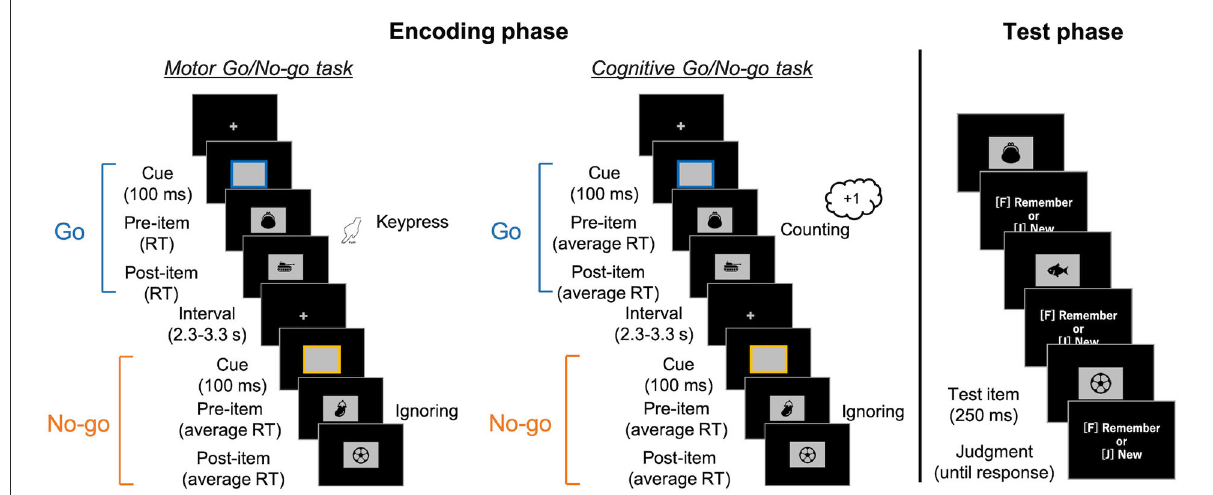
FIGURE1 Schematic illustrations of the encoding Go/No-go tasks (left) and the surprise recognition memory test in both (right). In the encoding tasks, the colored frames (i.e., response cue) were presented for 100ms, with random intervals varying between 2.3 and 3.3s. Participants were asked to press a key (in the motor task) or count it (in the cognitive task) when the Go cue with a particular color was presented. After the cue disappeared, a pre-item was presented. In the Go trials of the motor task, the pre-item was presented until participants’ keypress responses. It was then replaced by a post-item. As the post-item was presented for the response time (RT) in that trial, the presentation duration was the same for pre- and post-items. In the other conditions, pre-items initially appeared for a pre-recorded average RT. They were then replaced by post-items for the same amount of time. Next, they engaged in a simple calculation task for 1min. Finally, in the recognition memory test, images comprising old and newly added items were presented and participants judged whether they were presented in the encoding